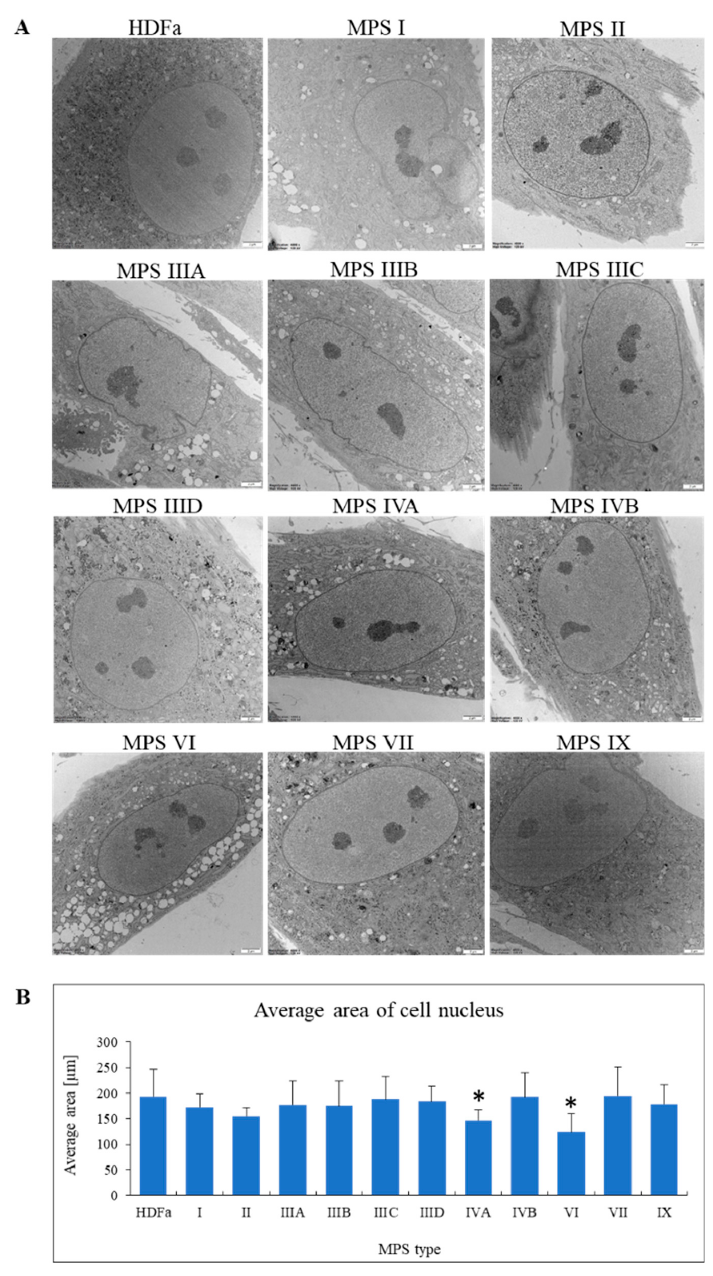
Figure 6. Morphology of nuclei in MPS fibroblasts in comparison to control cells (HDFa cell line). Representative electron micrographs are presented in ( A ) (size bars represent 2 mm). Quantification of changes in area of nucleus is presented in ( B ). Mean values ± SD are presented, with asterisks representing statistically significant ( p < 0.05) differences relative to the HDFa control.